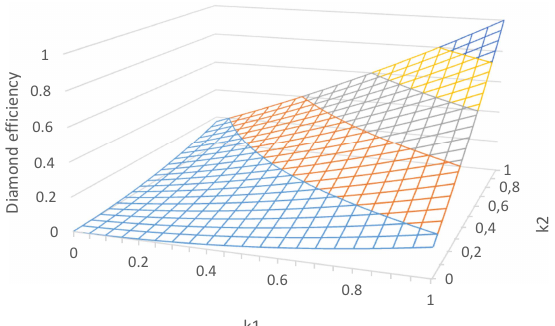
Figure 5. Behaviour of the diamond efficiency measure as a function of the perspectives’ efficiency scores when E C = E IP = k 1 and E I = E F = k 2 .